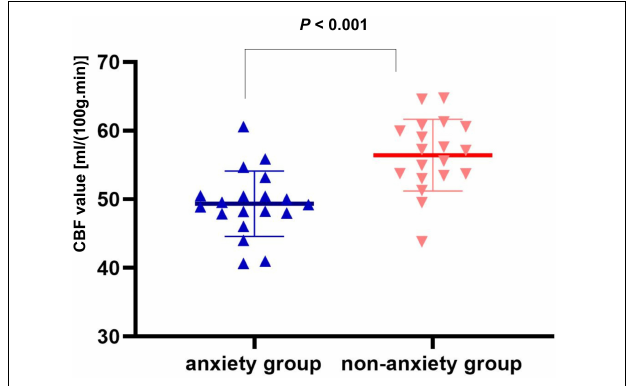
A previous study reported increased CBF in the posterior temporal-occipital area of patients with GAD when dealing with sentences induced anxiety, meanwhile, no significant